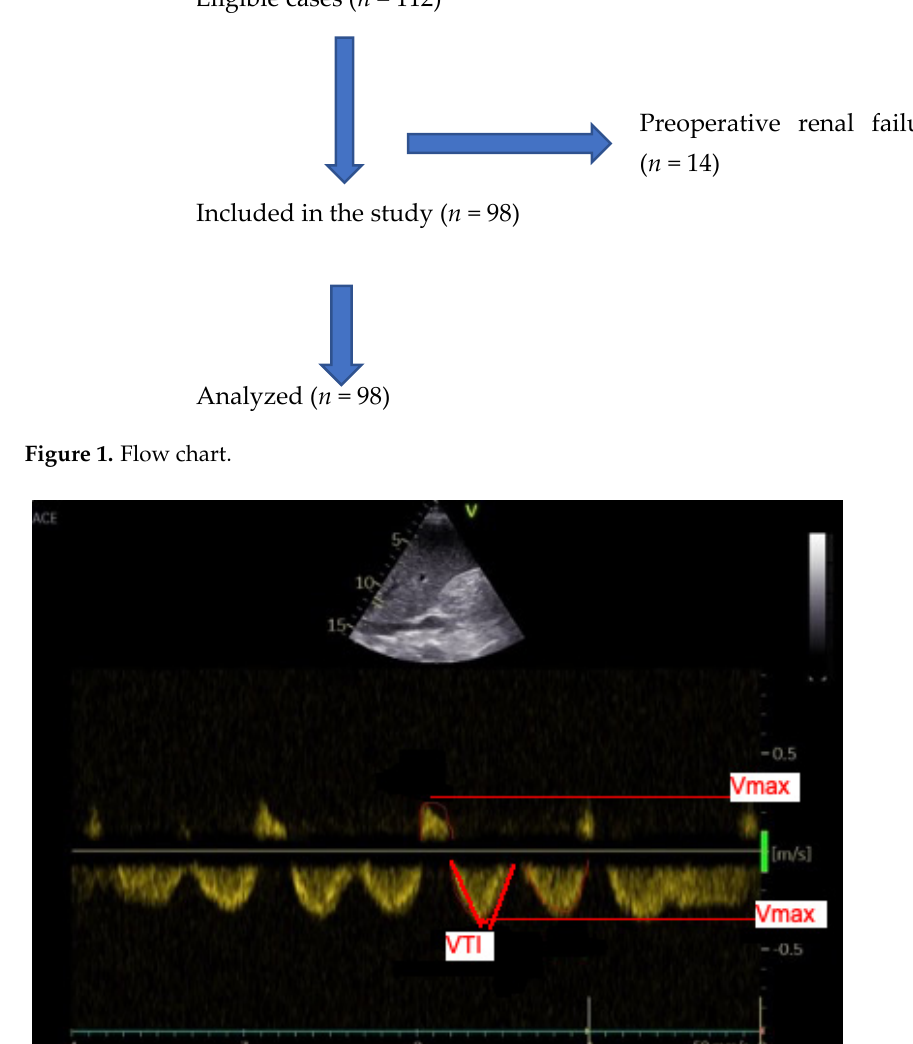
Figure 2. Doppler US analysis of the hepatic veins–maximum velocity and velocity-time integral were measured (a line was adjusted to the maximum point and continuous wave Doppler’s spectral curve was calculated by the machine. A and V waves are retrograde, S and D are anterograde waves).